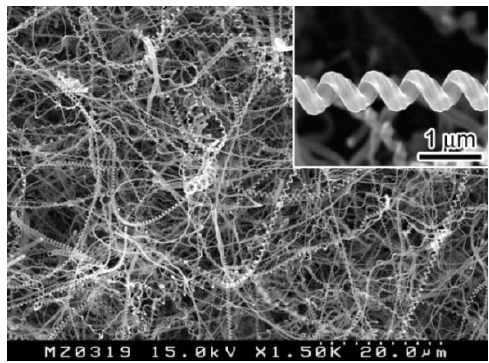
Figure 1. Scanning electron microscopy (SEM) micrograph of carbon nanocoils